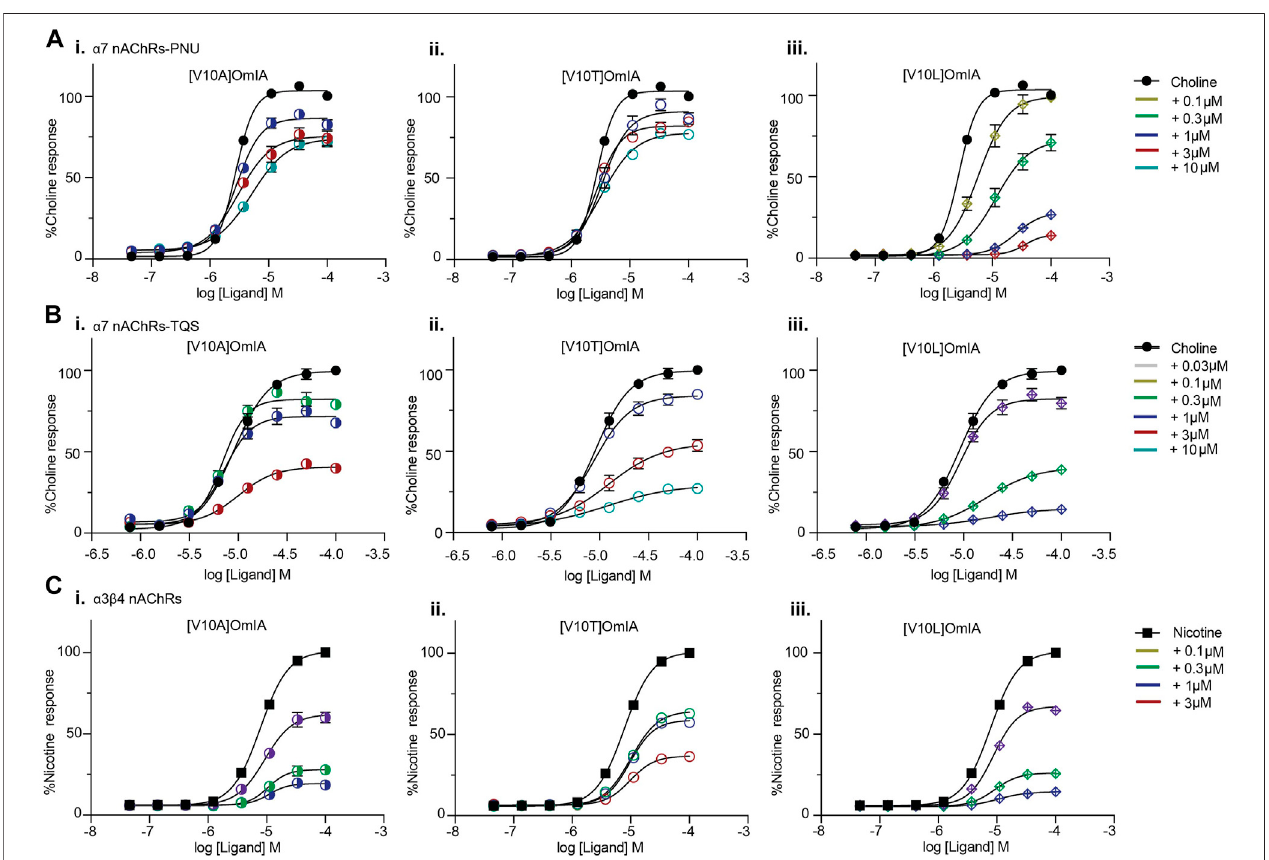
FIGURE 6 | Concentration-response curves for nicotine (black square) alone, choline alone (black round) in the presence of OmIA analogues at position 10 at α 7 nAChRs with the addition of nAChR type II PAM, PNU120596 (A) , TQS (B) and at α 3 β 4 nAChRs (C) . Data represent mean ± SEM of triplicate data from three independent